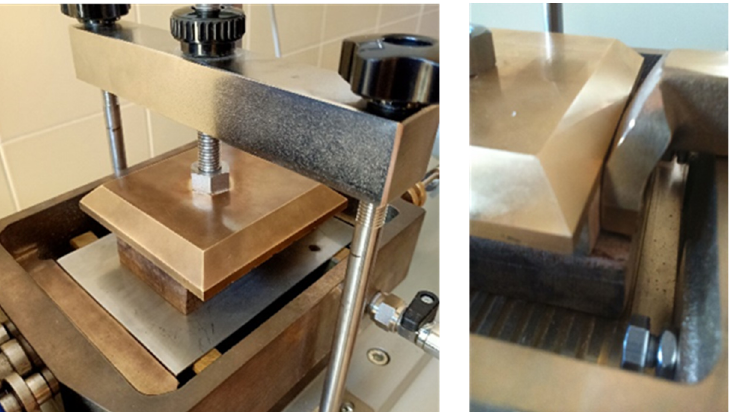
Figure 3. View of the layout of the timber-to-steel friction test (left) and detail of the evolution of the timber-to-timber test (right).